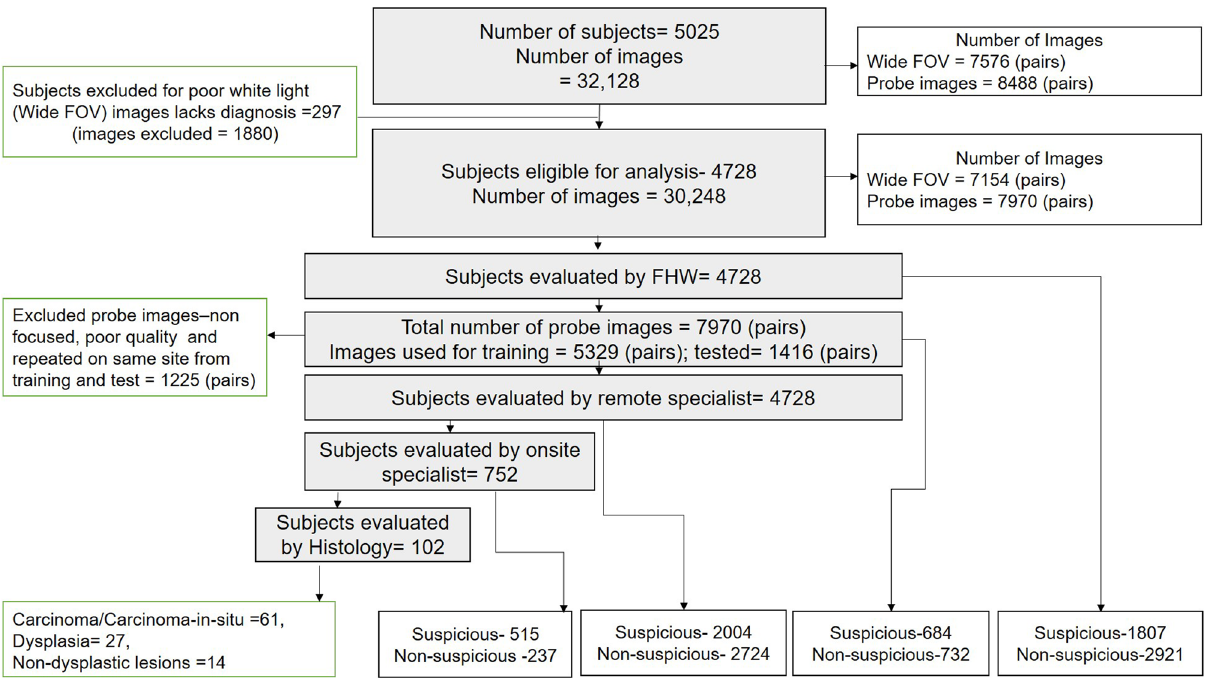
Figure 1. Study consort chart. A total of 5025 subjects were recruited for study according to inclusion and exclusion criteria. From 5025 subjects, a total of 32,128 images were captured using the phone with wide FOV (WLI and AFI = 7576 pairs) and probe with the focused view (WLI and AFI = 8488 pairs). More images were recorded of the same lesions using the probe. Among the subjects, 297 cases were not interpretable (WLI) by remote specialists and hence excluded from further analysis. All the subjects (n = 4728) were directly visualized by FHW and assessed by the remote specialist. The probe images were used for training/cross-validation (n = 5329 pairs) and testing (n = 1416 pairs). Out of 4728, 16% (n = 752) cases were seen directly by the onsite specialist. Onsite specialists identified 515 cases as suspicious and 20% (n = 102) underwent incisional biopsy and histology evaluation. Remote specialists and FHWs identified a suspicious lesion in 2004 and 1807 subjects respectively. FOV field of view, FHW Front-Line-Health Worker, WLI White Light Imaging, AFI